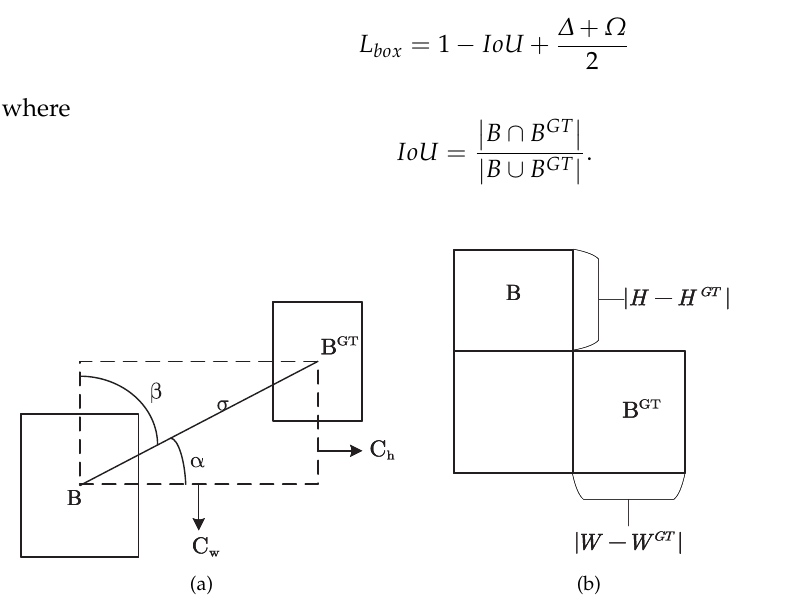
Figure 6. Ground truth and bounding box relationship diagram. ( a ) The scheme for calculating the loss function’s angle cost contribution. ( b ) The scheme of the relation of the IoU component